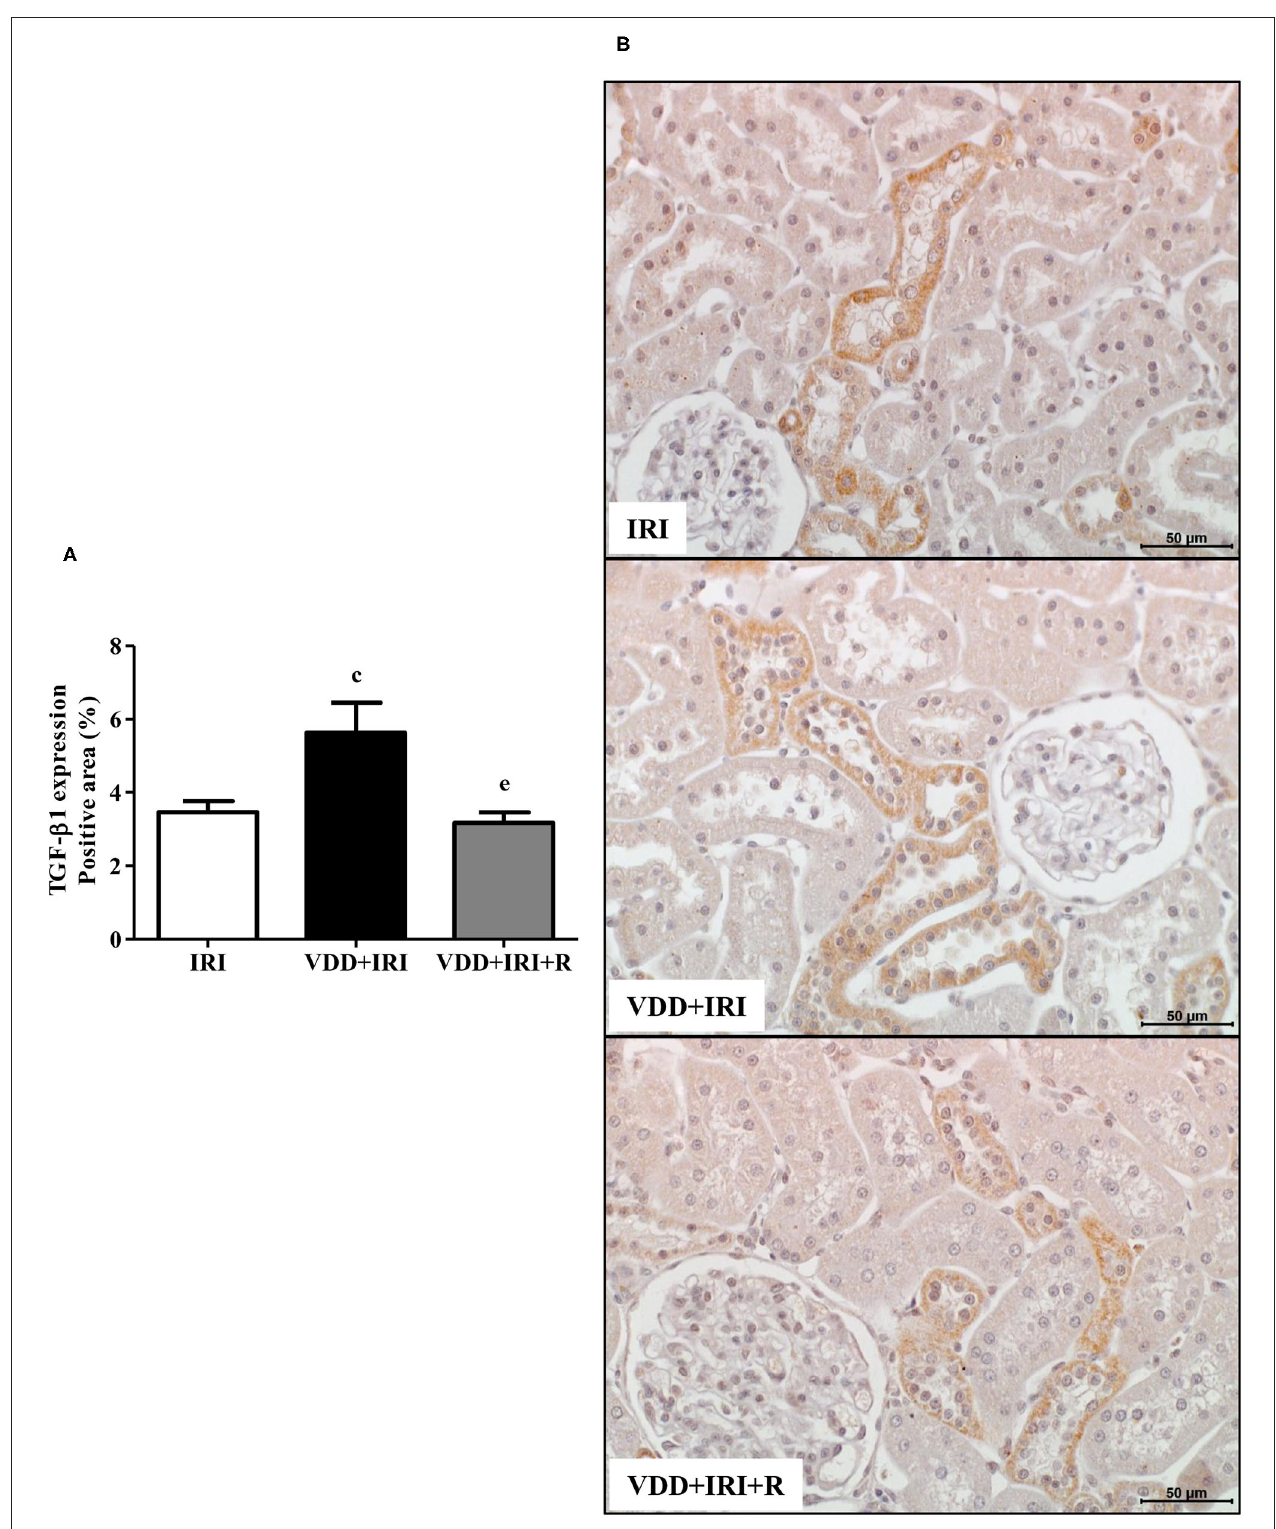
FIGURE 5 | Immunohistochemical analysis for transforming growth factor- β 1 (TGF- β 1) expression in the kidney tissue. (A) Bar graph of TGF- β 1 values. (B) Representative photomicrographs of immunostaining for TGF- β 1 in the renal cortex from an IRI, VDD + IRI and VDD + IRI + R rat ( × 400). Note that vitamin D replacement restored the expression of TGF- β 1 in the VDD + IRI + R rats. Data are mean ± SEM. c p < 0.05, vs. IRI; e p < 0.01 vs. VDD + IRI. VDD, vitamin D deficiency; R, vitamin D replacement. Diet protocol: IRI, standard diet for 120 days; VDD + IRI, vitamin D-free diet for 120 days; and VDD + IRI + R, vitamin D-free diet in the first 30 days and standard diet in the last 90